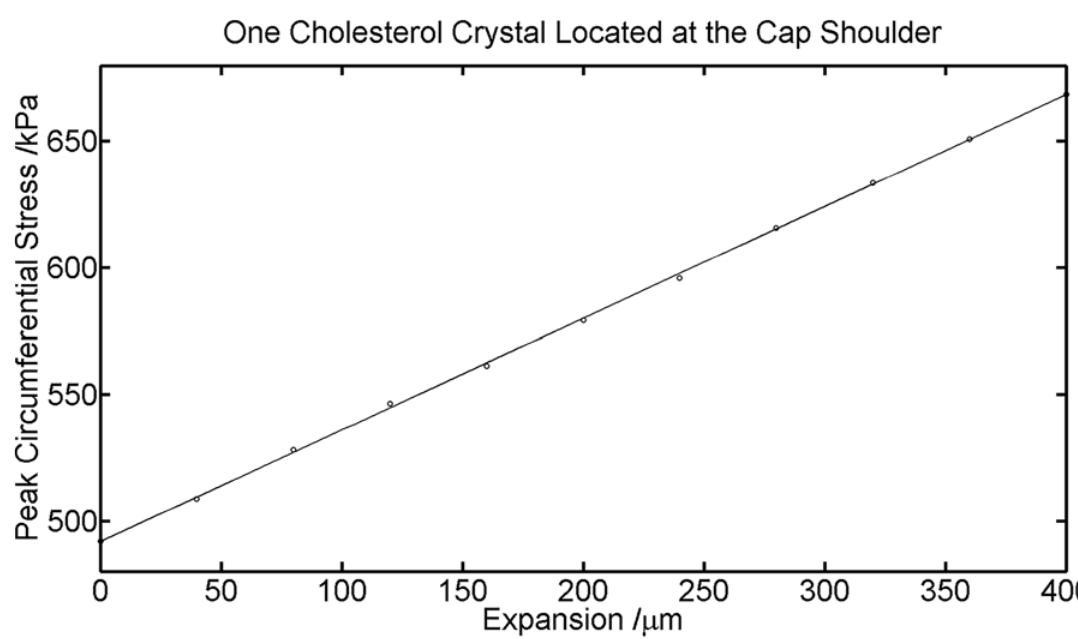
Fig 4. Peak Circumferential Stress (PCS) with Varying Expansion of One Cholesterol Crystal at the Cap